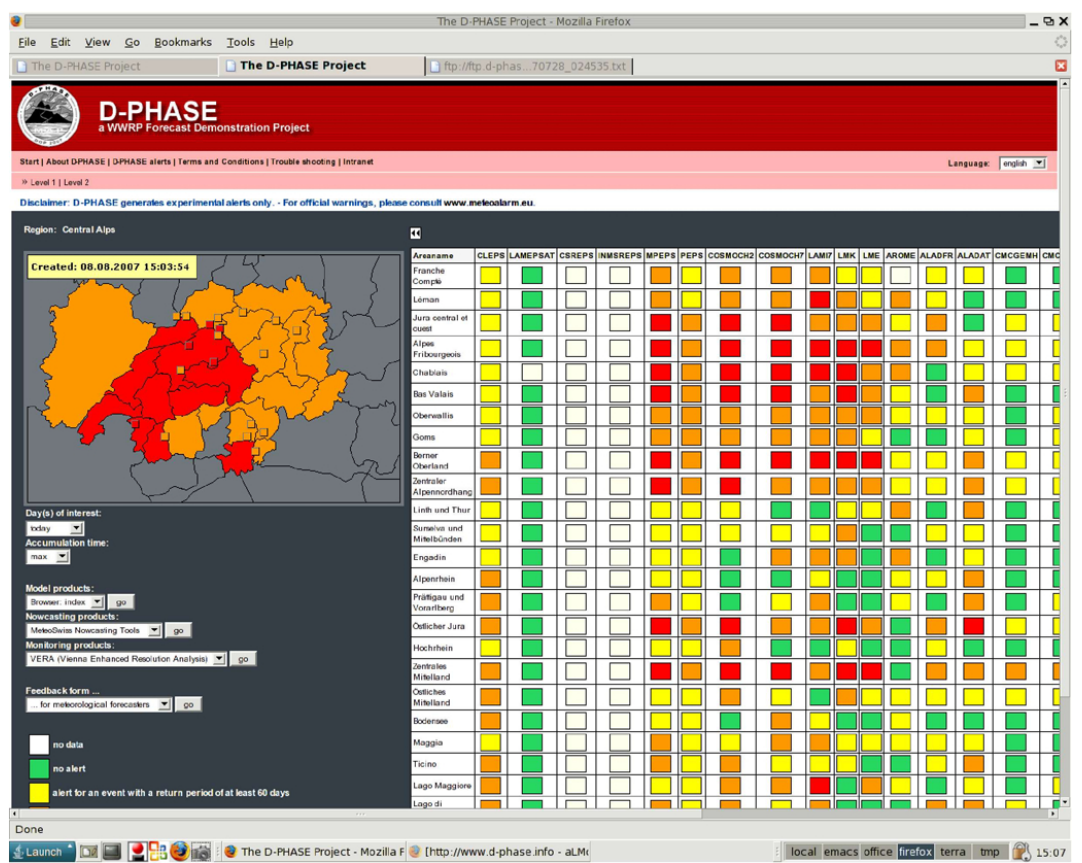
Fig. 1. Screenshot of the D-PHASE VP for 8 August 2007, level 2 (regional view). Each line corresponds to a chatchment (those visible on the map to the left) and each column informs on the results from one of the models (note that columns extend beyond those shown). Green, yellow, orange, and red areas correspond to the defined “traffic light color coding” warning levels (white indicates no